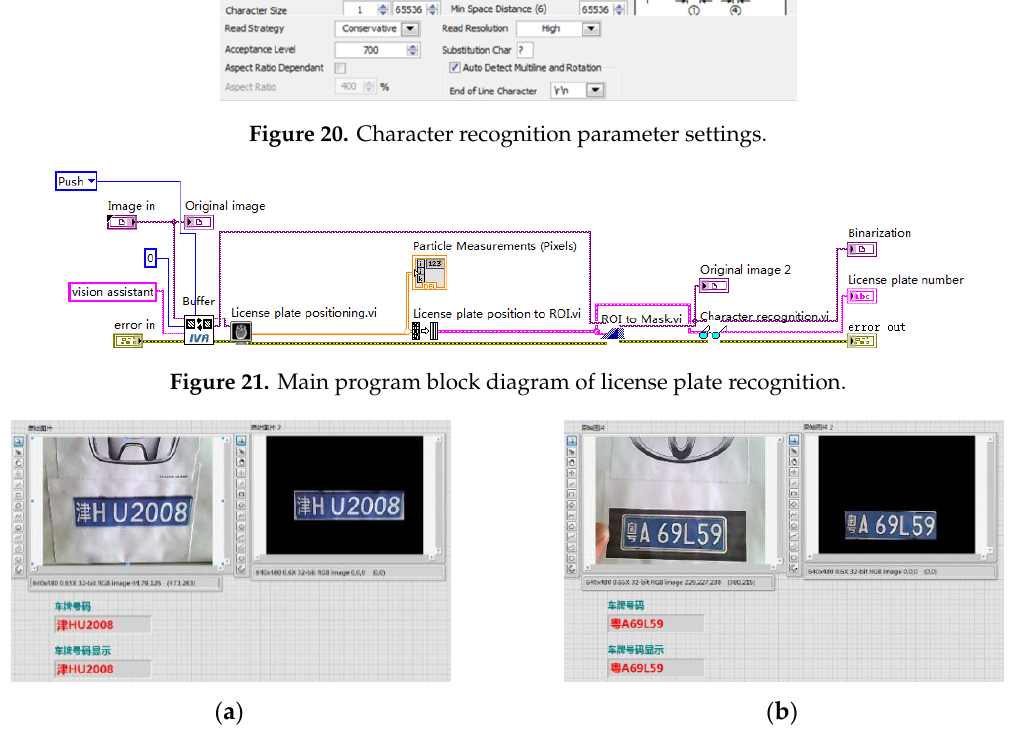
Figure 22. License plate recognition results: ( a ) License Plate 1 and ( b ) License Plate 2.